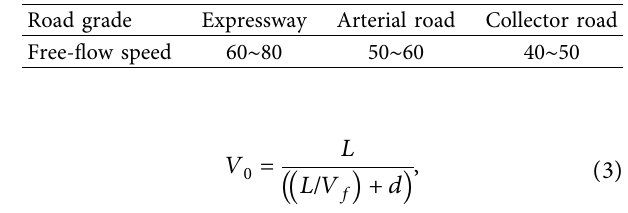
Table 1: Recommended value of free-flow speed for different grades of roads